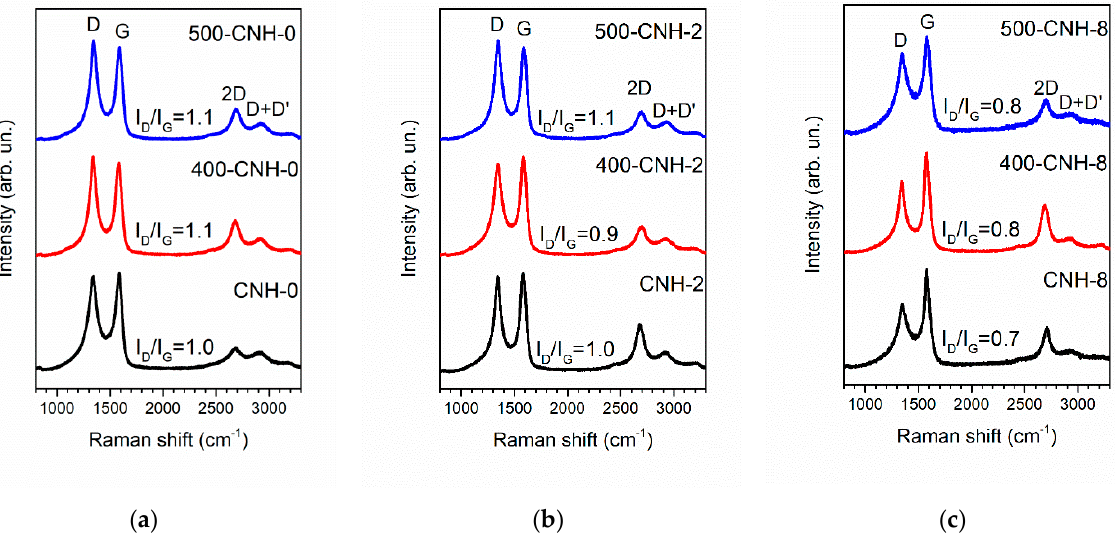
Figure 3. Raman spectra of initial and thermally oxidized samples CNH-0 ( a ), CNH-2 ( b ), and CNH-8 ( c ).